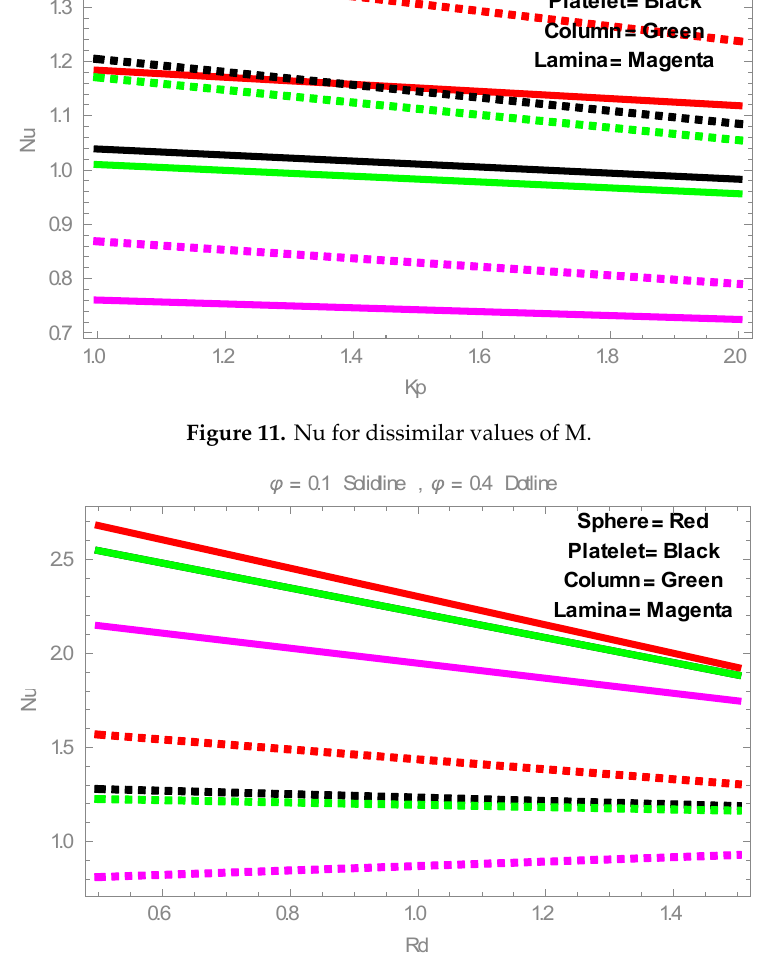
Figure 12. Nu for dissimilar values of φ.